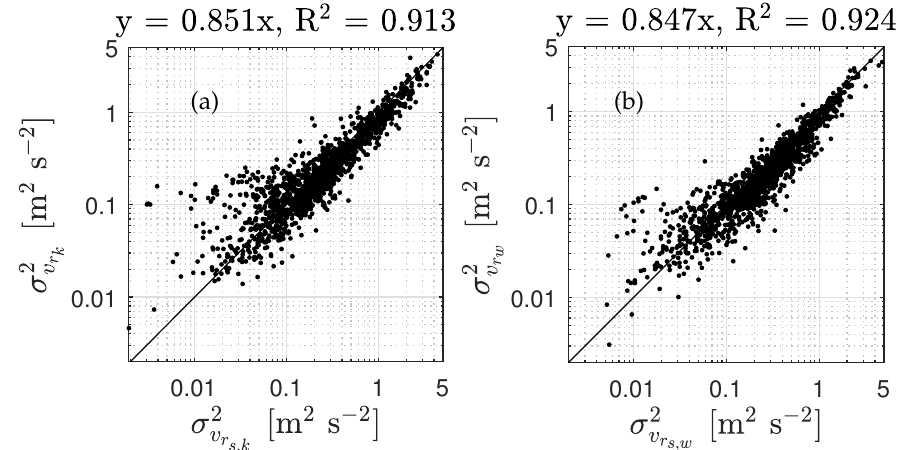
Figure 7. Scatter plot of the radial velocities’ variances of the WindScanners and the sonic anemometer in the beam direction of the k lidar ( a ) and w lidar ( b ). The results of a linear regression through the origin are also shown together with the coefficient of determination R 2